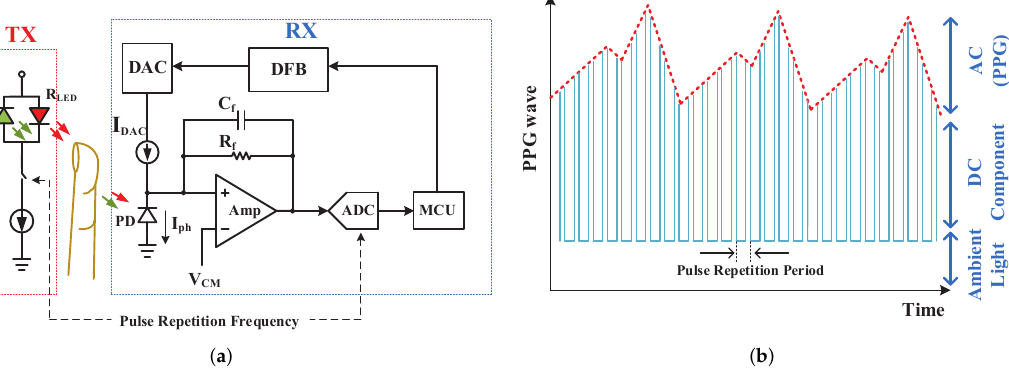
Figure 1. ( a ) Traditional implementation of PPG signal acquisition system. ( b ) Typical PPG wave with DC and AC components.